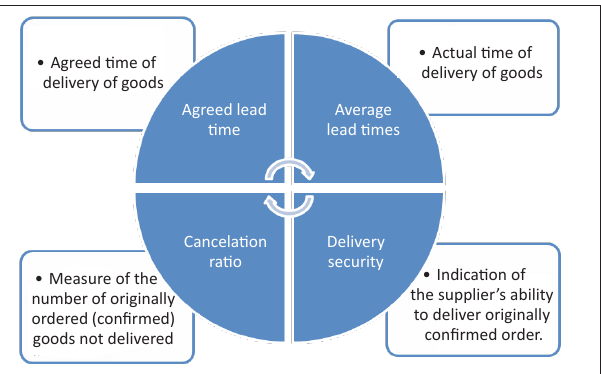
FIGURE 1: Logistic performance indicators used by Company